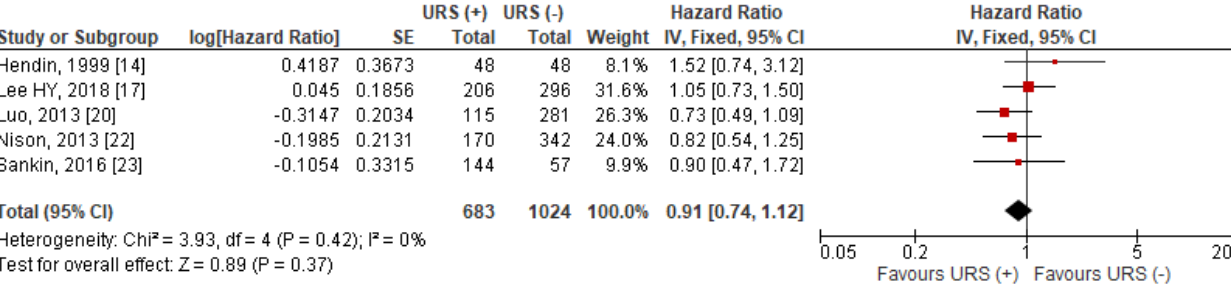
Figure 6. Forest plot and meta-analysis of metastasis-free survival (MFS) [14,17,20,22,23]. CI = confidence interval; IV = inverse variance; SE = standard error; URS = ureteroscopy.